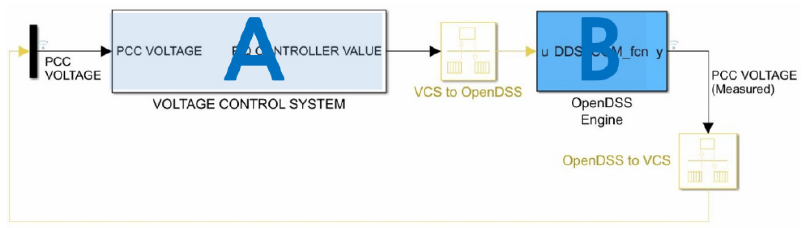
Figure 7. Illustration of the voltage control system model in MATLAB/Simulink.